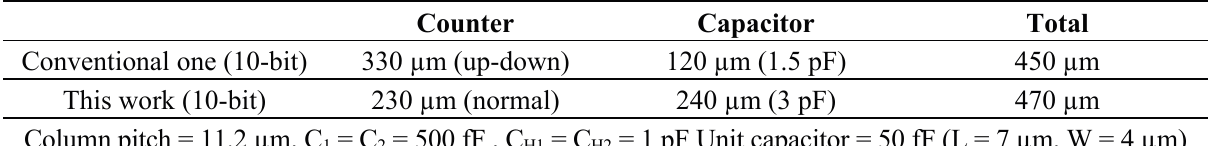
Table 2. Comparison of chip size per one column.